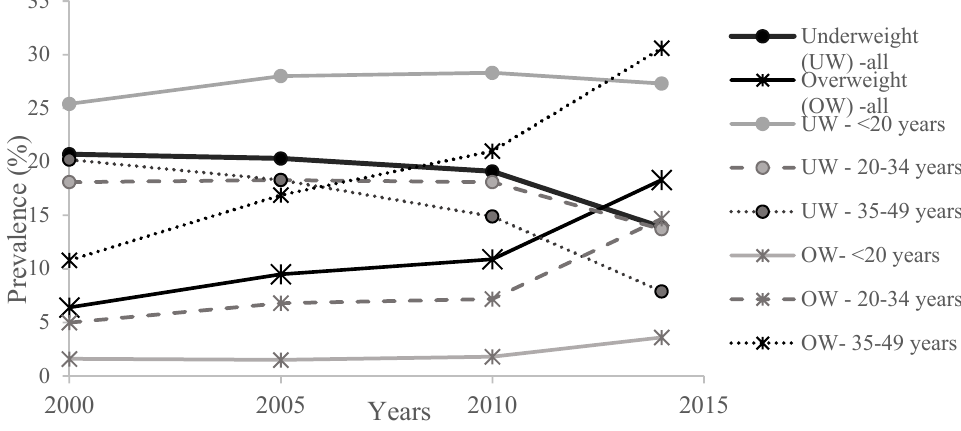
Figure 1. Percentage of underweight and overweight women by age groups and year of survey.